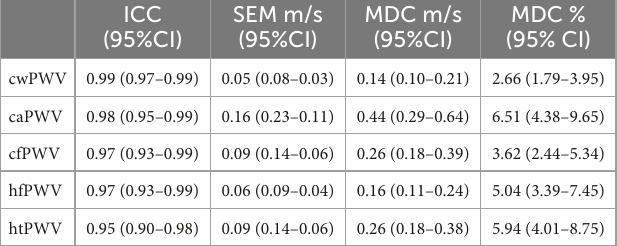
TABLE 1 Repeatability of baseline pulse-wave velocity measurements [Data points = 54 (27 subjects × 2 time points)].